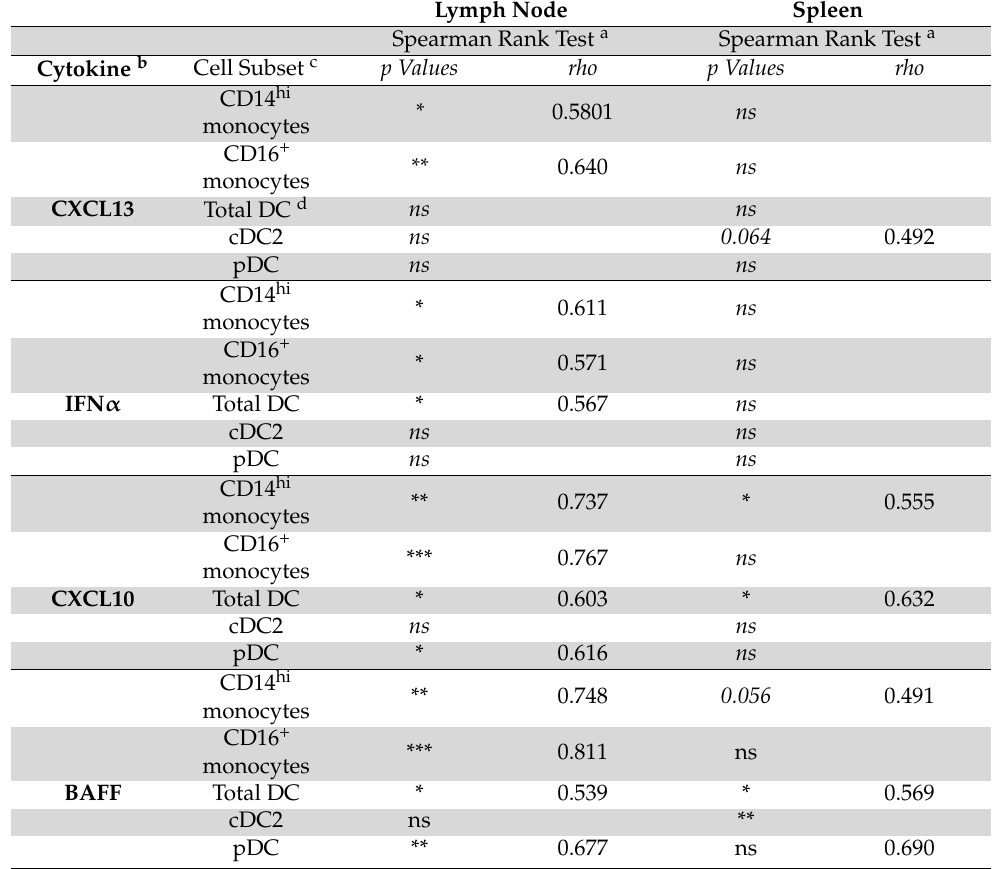
Table 1. Monocytes and DC: Correlation with